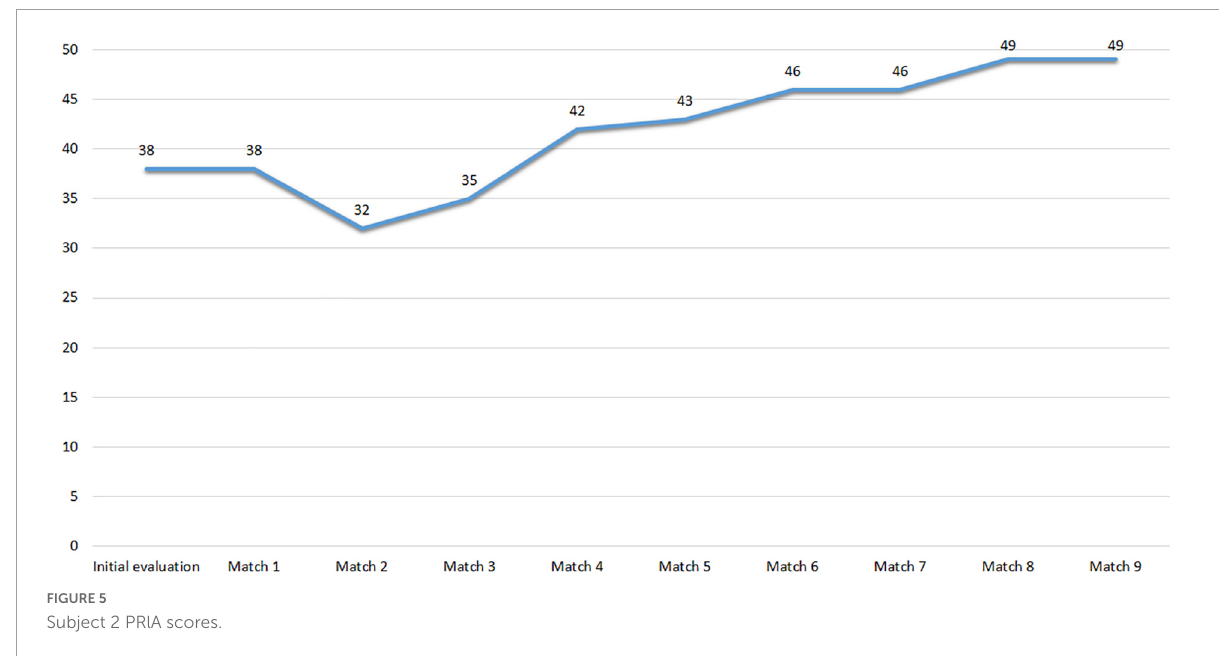
FIGURE5 Subject 2 PRlA scores.